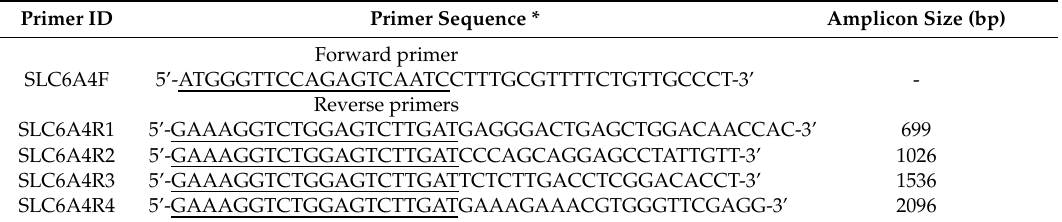
Table 1. Primer sequences used to amplify the SLC6A4 promoter